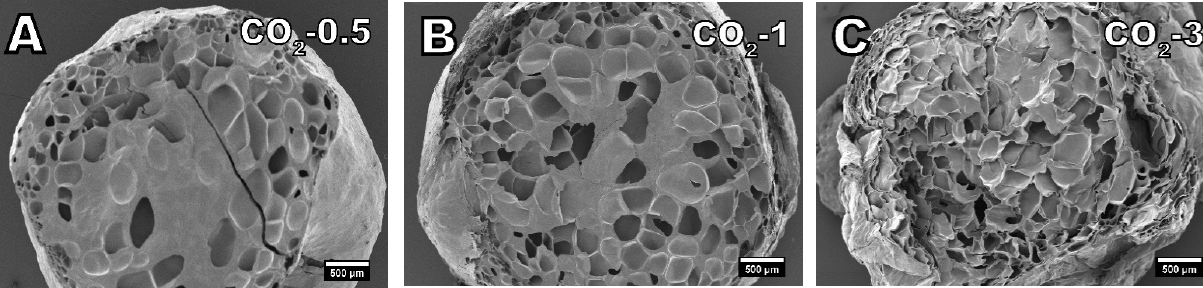
Figure 3. SEM images of samples foamed with isobutane in amounts of ( A ) 1%, ( B ) 3%, and ( C ) 5%. (15× magnification).